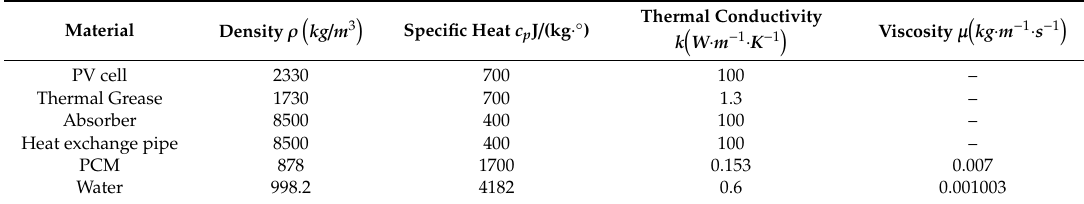
Table 2. Property parameters of